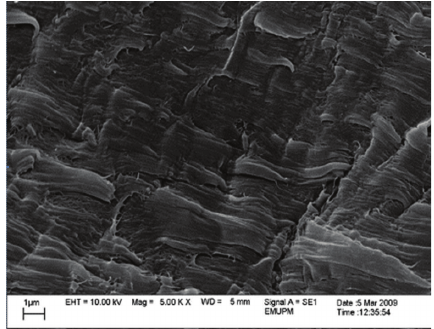
Figure 6: SEM micrograph of shape and size distribution of nano 𝛼 -Al 2 O 3 particles.